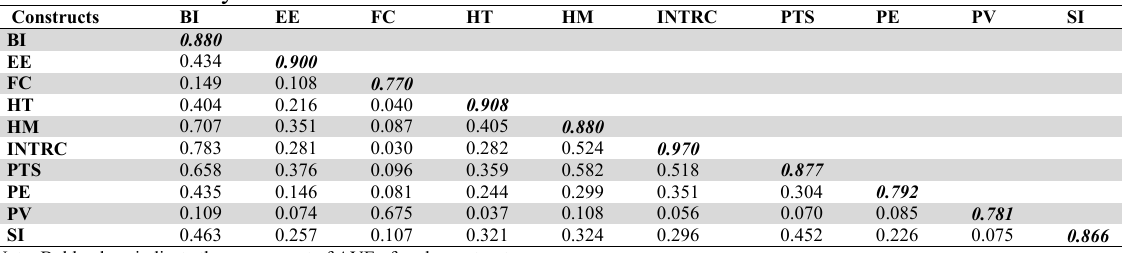
Discriminant validity of measurement model Constructs